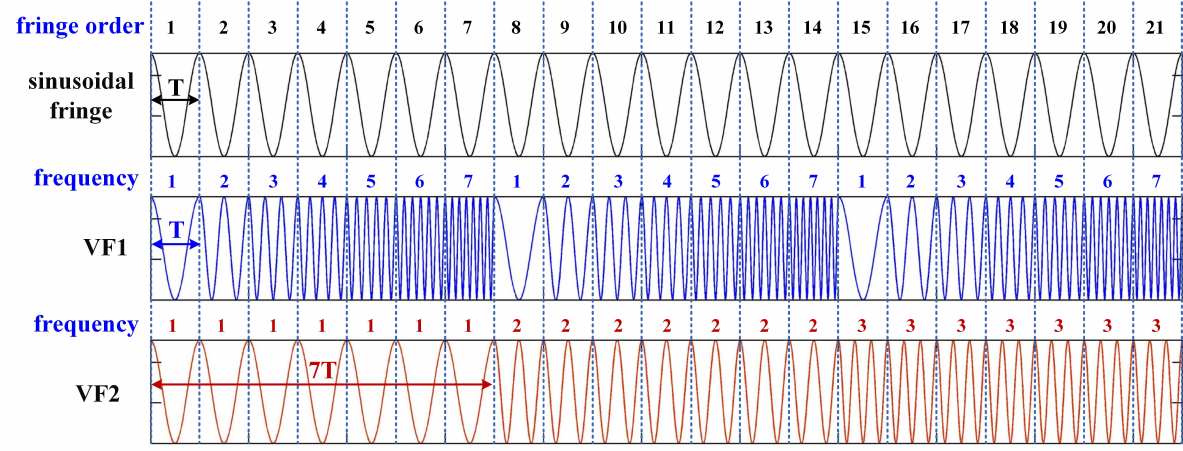
Figure 1. Sinusoidal and coded fringes of the first 21 sinusoidal periods, in which T is the period of the sinusoidal